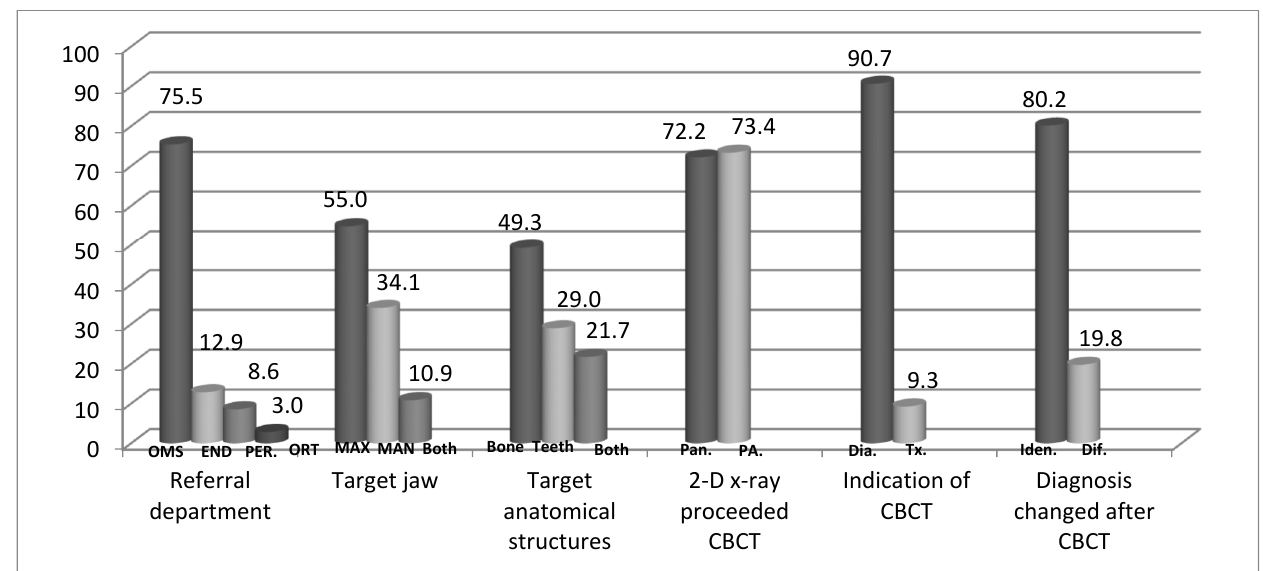
Figure 1. Distribution of The Study Population According to The Referring Department and Clinical Data Regarding The Patterns of CBCT Usage. OMS-Department of Oral and Maxillofacial Surgery, ENDO-Department of Endodontics, PER-Department of Periodontology, ORT-Department of Orthodontics, MAX-Maxilla, MAN-Mandible, Pan-Panoramic, PA-Periapical, DIA-Diagnostic, Tx-Treatment, IDEN-Identical, Dif-Different.